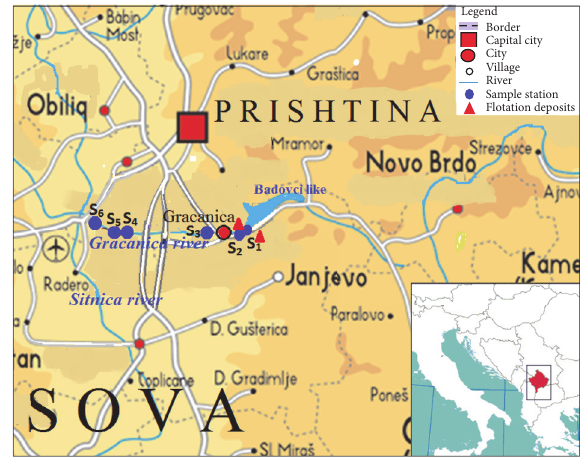
Figure 1: Study area, sampling stations, and flotation